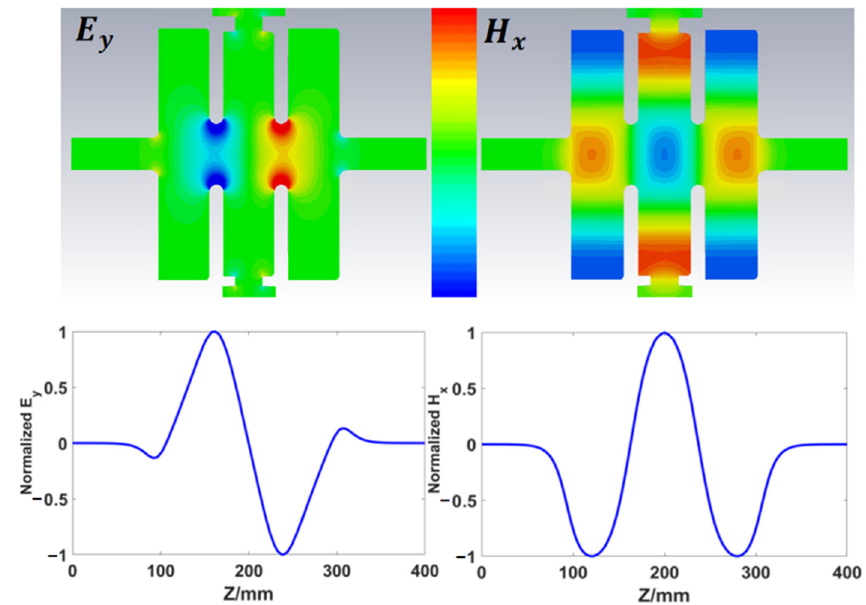
Figure 3. The electromagnetic field of the working mode.